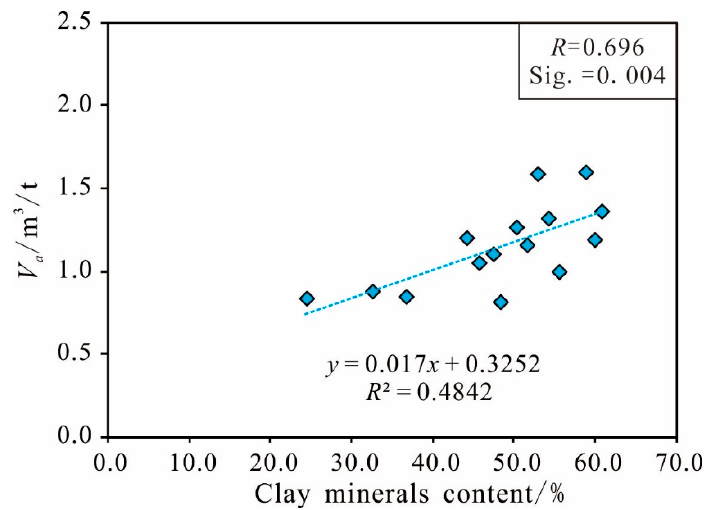
Figure 12. Significant positive relationship between V a and clay minerals content. Brittle Mineral